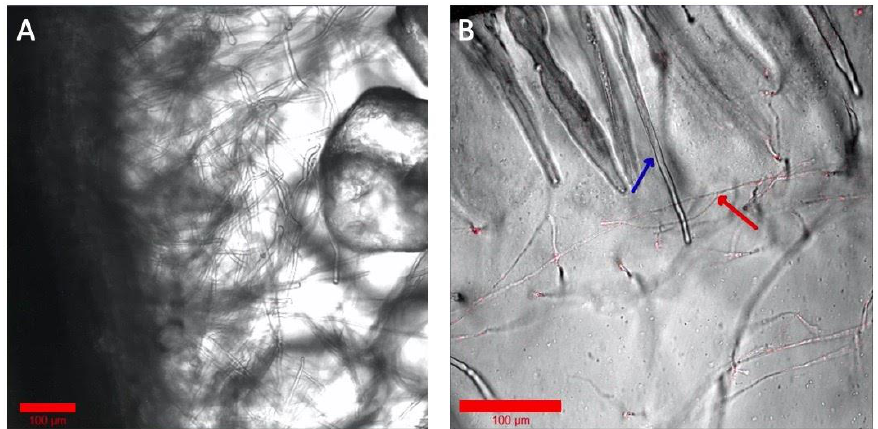
Figure 5. Examination of solid and gel media types in Imaging EcoFABs. ( A ) Axenic B. distachyon grown on sand, watered with 10% MS. ( B ) B. distachyon grown wih H1-RFP N. crassa in phytagel with 10% MS. The blue arrow shows a root hair and the red arrow shows hyphae. Colorized and annotated in Zen (Zeiss).